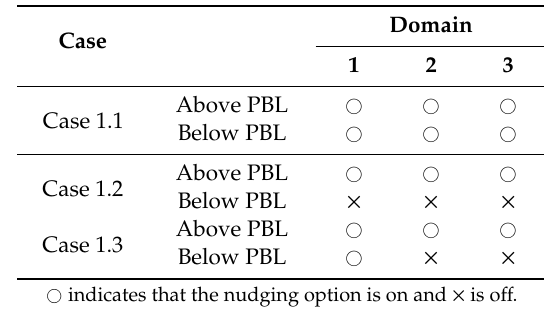
Table 3. Cases used to investigate the e ff ect of nudging height on the vertical wind profile.